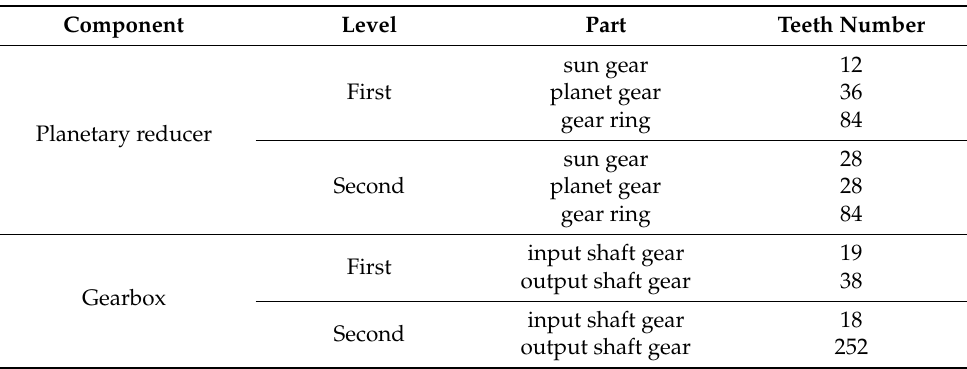
Table 3. Transmission parameters of the pitching moving